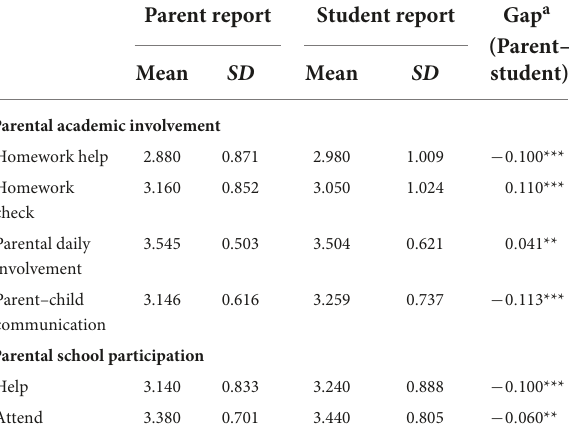
TABLE 1 Parents’ versus students’ perceptions on parental involvement.